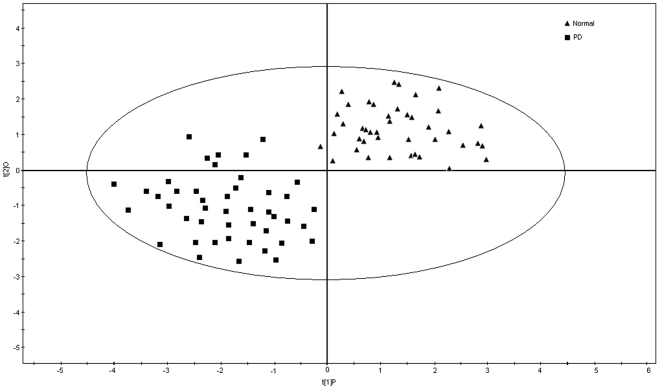
PLS-DA analysis of normal and PD serum elements.PLS-DA score's plot displays a significant separation between control subjects (n = 42) and unmedicated PD patients (n = 45) using complete digital maps. The observations coded according to class membership: triangle is normal and rhombus is PD. Each data point on a plot represents one individual.